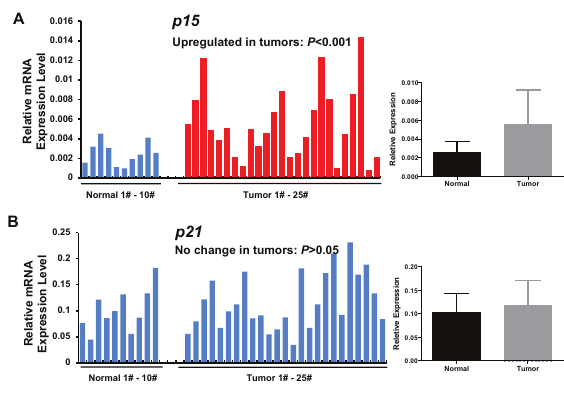
Figure 2: p15 and p21 expression in adenocarcinoma of esophago- gastric junction tissue samples.